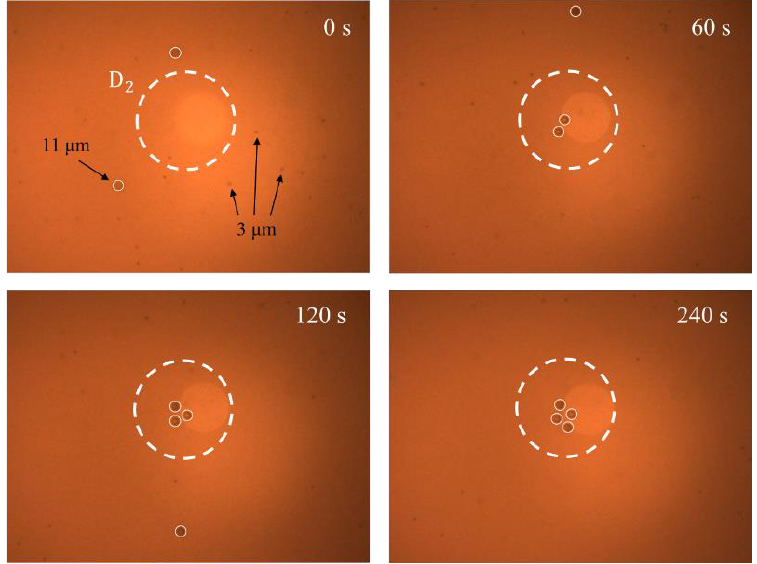
Figure 8. Particle sorting based on voltage modulation effect at 0, 60, 120 and 240 s, respectively. Note that the laser power is 75 W/cm 2 , the voltage amplitude is 35 V pp , and the driving frequency is 25 kHz.